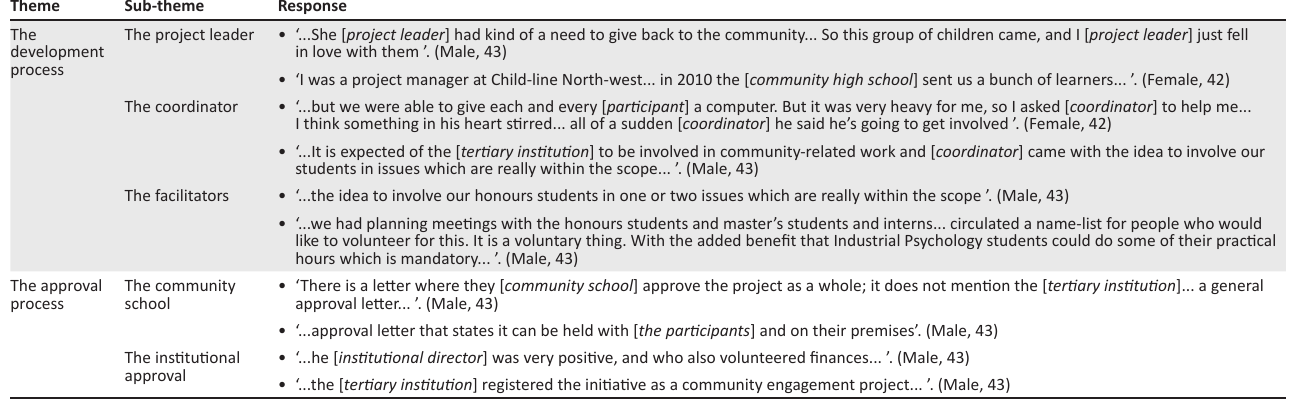
TABLE 3: Development and approval of the corporate social responsibility